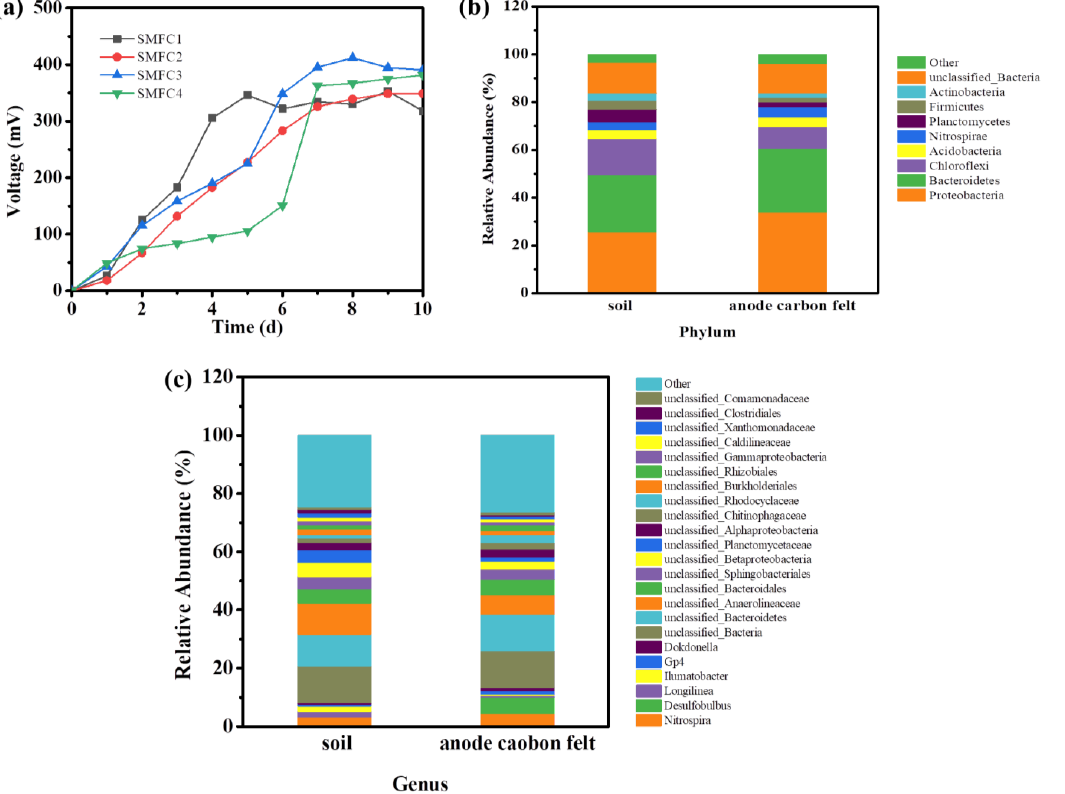
Figure 2. The voltage output of the four SMFCs ( a ) and the microbial community analysis of the anodic biofilm of the SMFC ( b , c ).